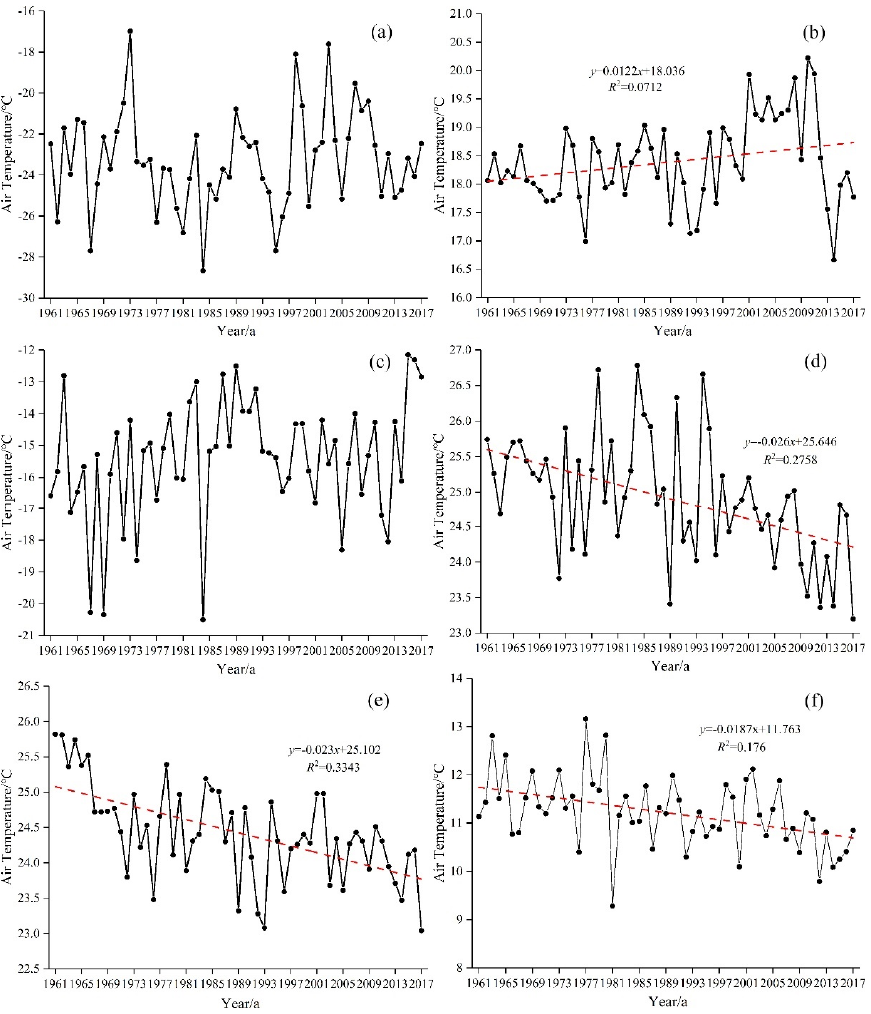
Figure 6. Exceptional time series of air temperature in the CTMR. ( a ) The wintertime changing trend in BYBLK; ( b ) the summertime changing trend in BLGT; ( c ) the wintertime changing trend in QT; ( d ) the summertime changing trend in KP; ( e , f ) the summertime and autumn changing trend in KQ, respectively.